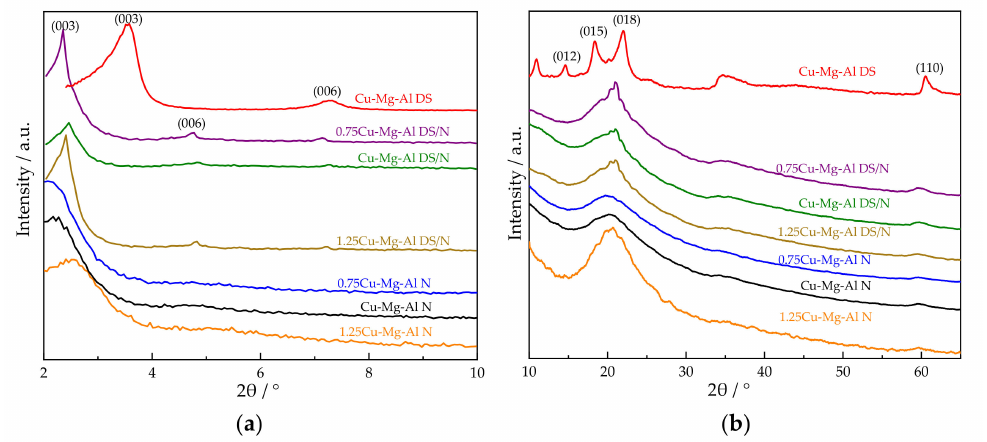
Figure 1. XRD diffraction patterns of Cu-Mg-Al DS, xCu-Mg-Al DS/N, and xCu-Mg-Al N at different 2 θ ranges: ( a ) 2 θ range of 2 ◦ –10 ◦ ; ( b ) 2 θ range of 10 ◦ –65 ◦